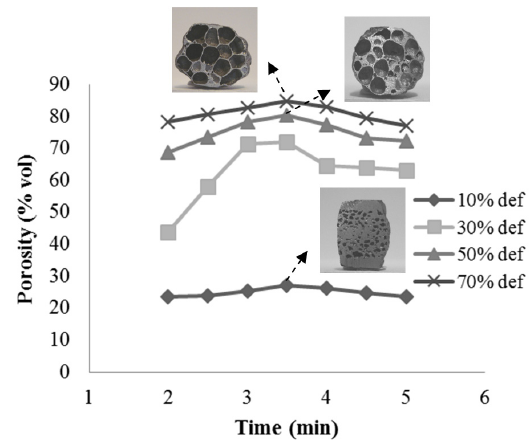
Table 1. The densities of precursor samples depending upon the amount of deformation rates. Deformation Rate (%)